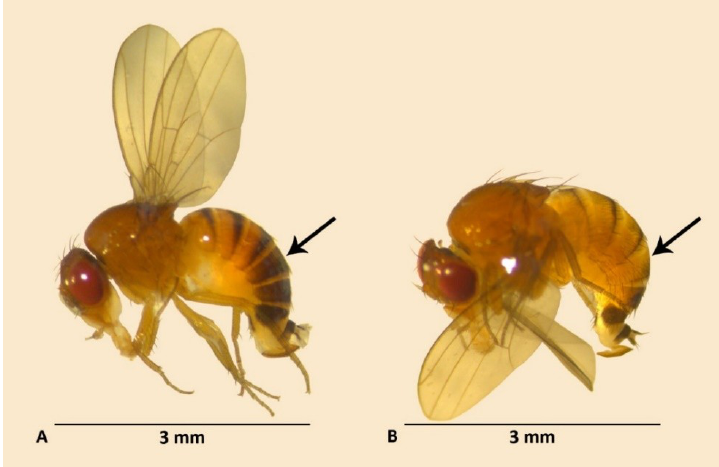
Figure 1. Characteristic D. suzukii females of the two phenotypes: ( A ) winter morph female and ( B ) summer morph female. Arrow points toward the fourth abdominal segment which is completely melanized in adult females displaying a winter phenotype. In males, this difference occurs on the third abdominal segment. Photographs: